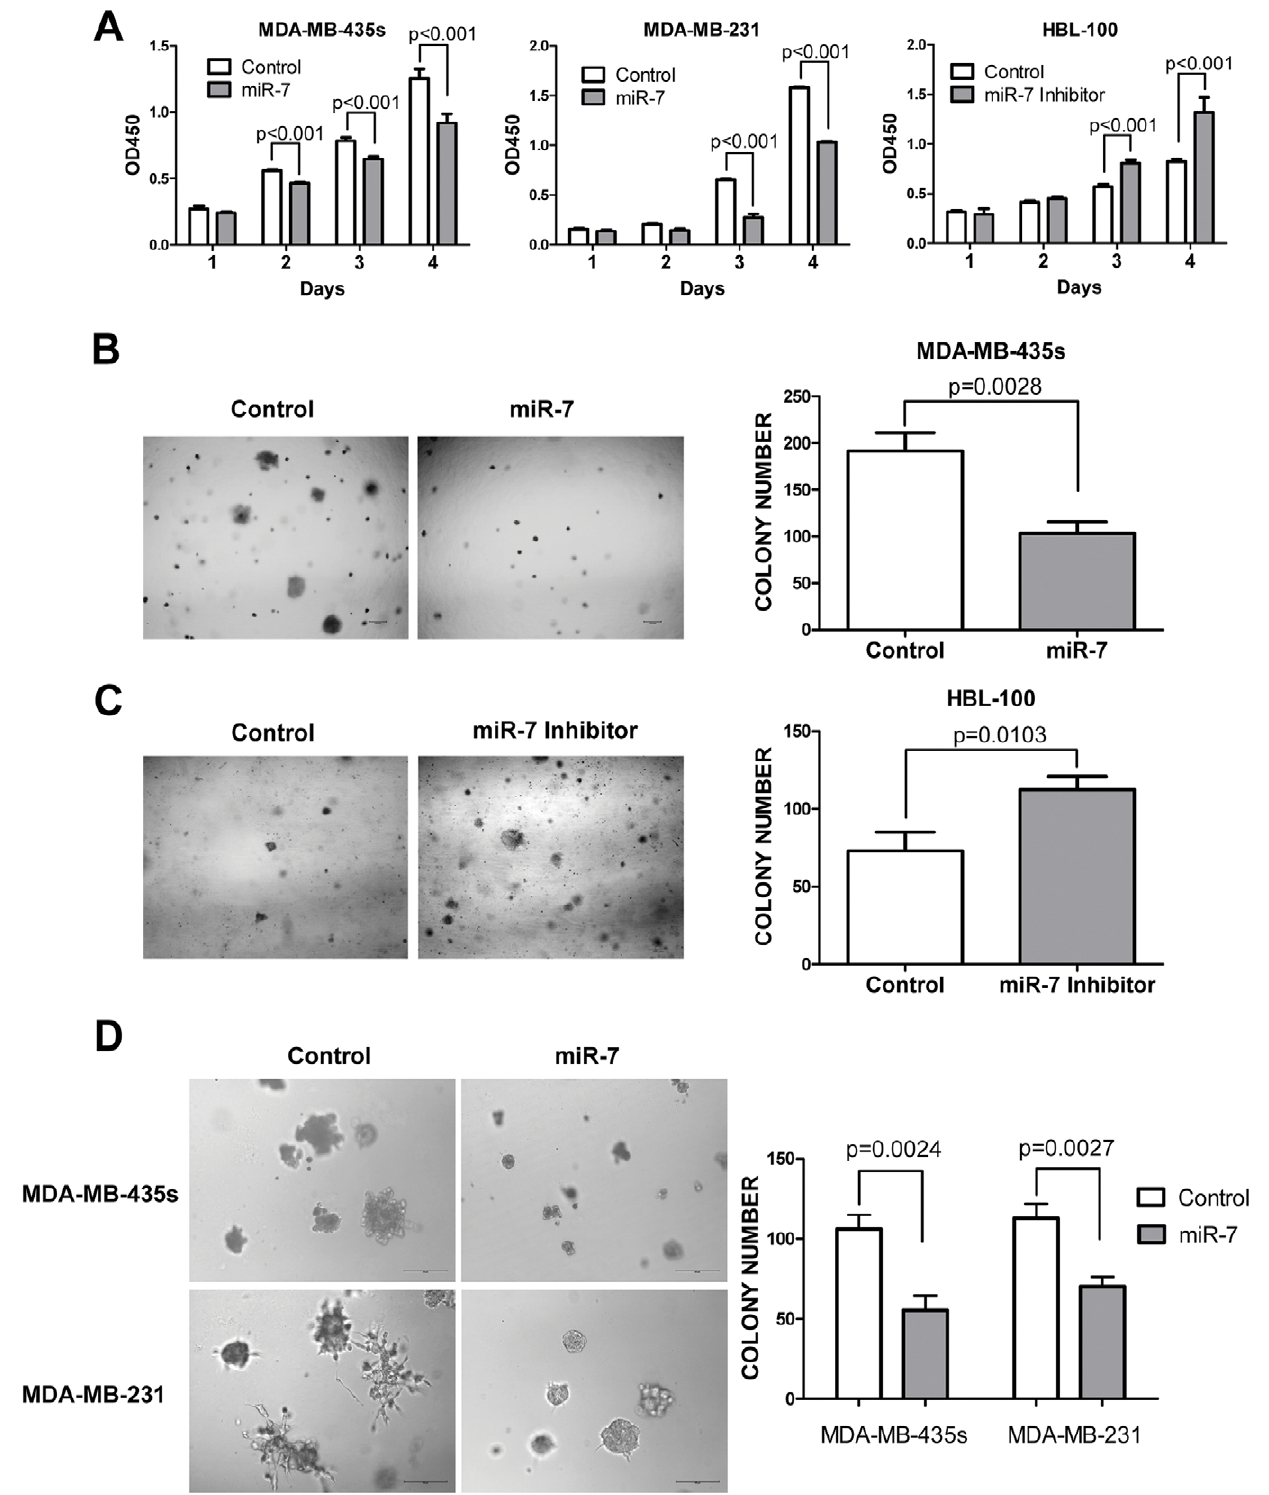
Figure 5. miR-7 inhibits breast cancer cell tumorigenesis invitro . (A) miR-7 decreases MDA-MB-435s and MDA-MB-231 cell proliferation in vitro and inhibition of endogenous miR-7 expression promotes HBL-100 cell monolayer proliferation. (B) miR-7 inhibits MDA-MB-435s anchorage independent growth in soft agar. (C) Inhibition of miR-7 promotes HBL-100 cell anchorage independent growth in soft agar. (D) Morphology of MDA- MB-435s and MDA-MB-231 cells cultured in three-dimensional Matrigel after transfection with mature miR-7 or the control miRNA.